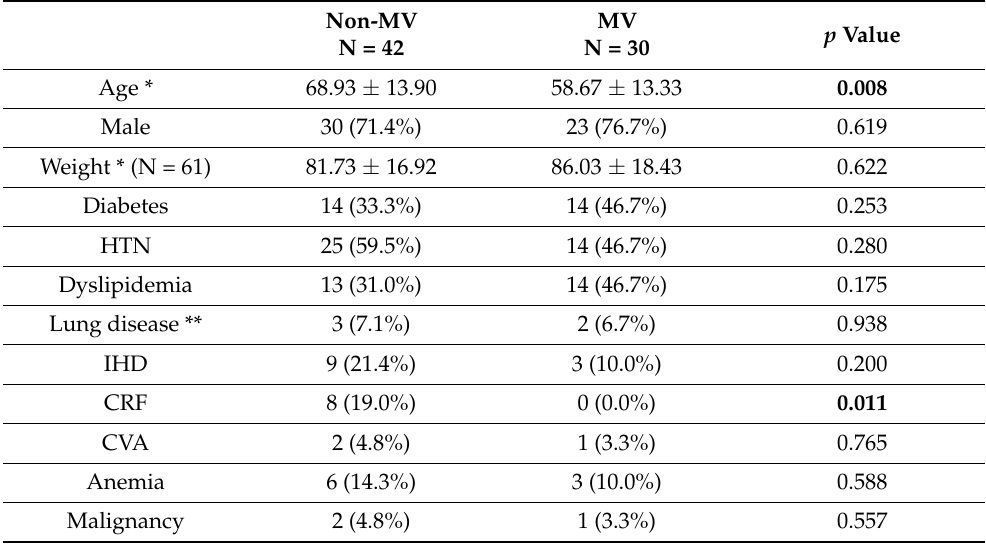
Table 1. Demographic and clinical features of COVID-19 patients who required intubation and mechanical ventilation compared to those who did